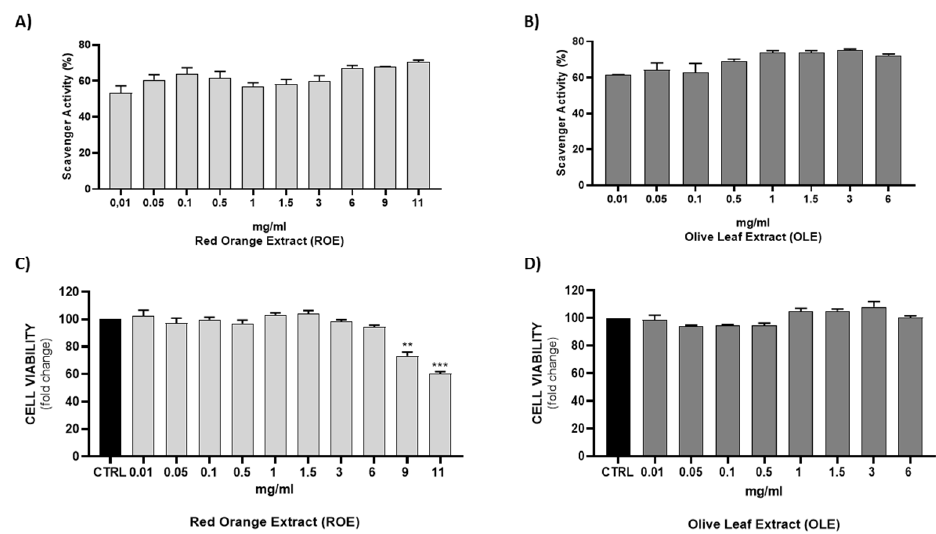
Figure 1. DPPH radical scavenging activity of ( A ) ROE and ( B ) OLE at different concentrations. Results are expressed as a percentage of inhibition. Evaluation of HepG2 cell viability in the absence or presence of ( C ) ROE and ( D ) OLE at different concentrations for 72 h. Results are expressed as mean ± SEM. Significant vs CTRL: ** p < 0.005; *** p < 0.0005.